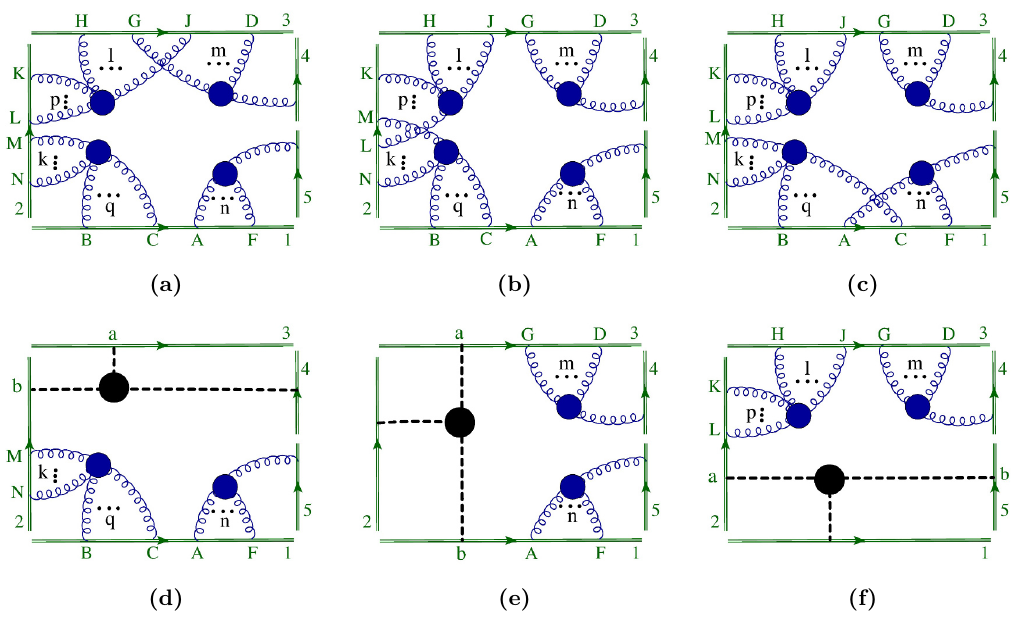
Figure 21. Fused-Webs for Cweb W (1 , 1 , 1 , 1)